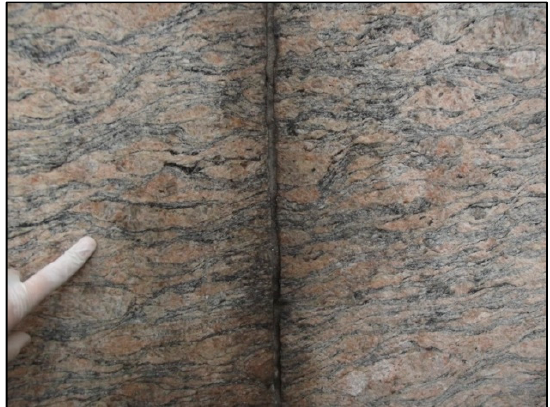
Figure 3. Phacoidal gneiss.